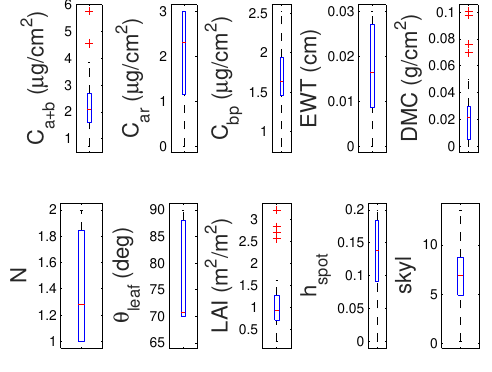
Figure 4. Parameter distribution obtained from the simulated reflectances of S. densiflorus .